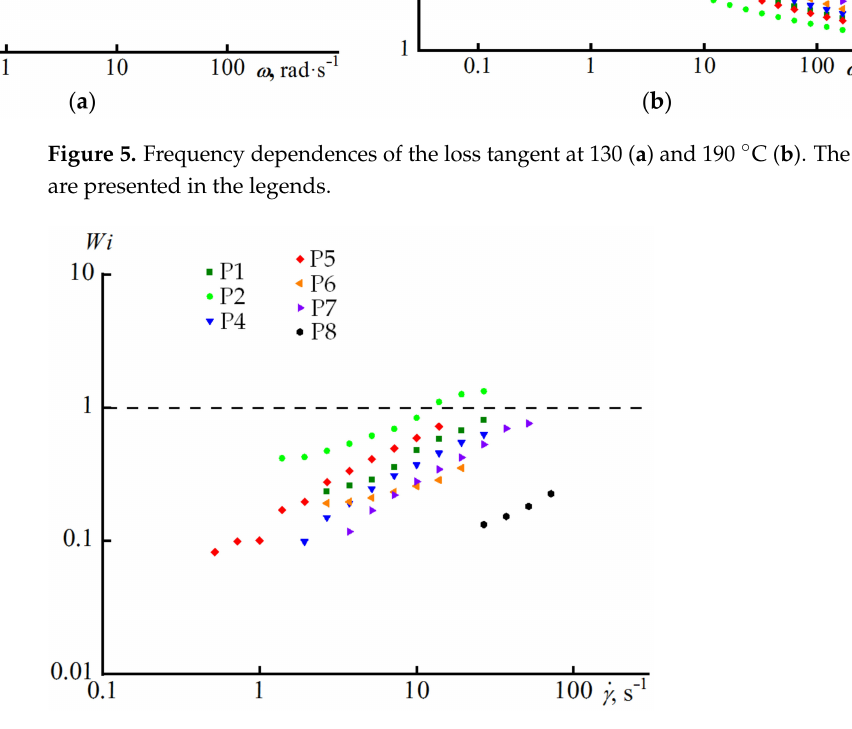
Figure 6. Shear rate dependences of the Weissenberg number at 190 ◦ C. The polymer numbers are presented in the